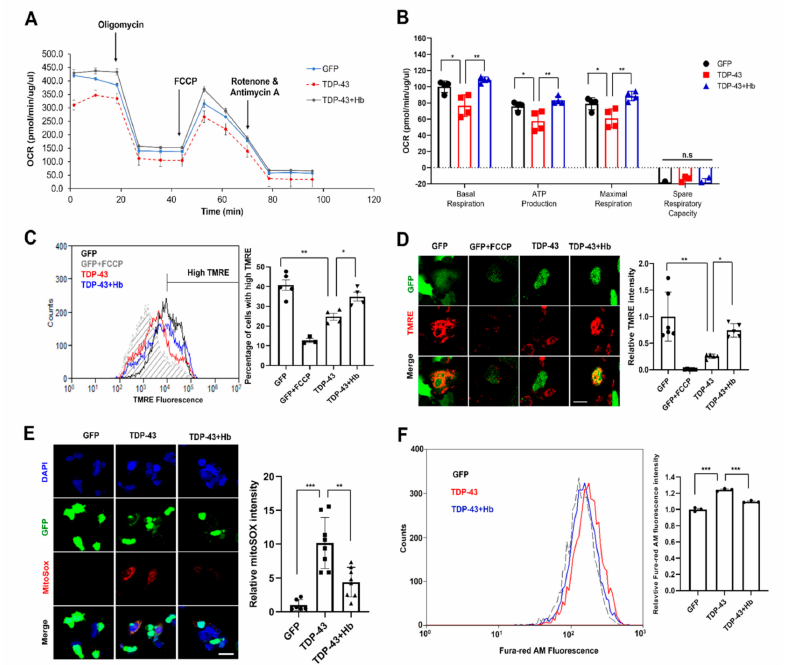
Figure 5. Hydroxocobalamin attenuates TDP-43-induced mitochondrial dysfunction. SH-SY5Y cells were infected with the GFP- or GFP-tagged human WT TDP-43 lentivirus and grown for 2 days. The day before harvest, cells were treated with Hb (10 µ M) for 24 h. ( A ) Mitochondrial function was analyzed by detecting basal respiration, ATP production, maximal reserve and respiratory capacity with a Seahorse XF analyzer. The OCR was normalized to the total protein concentration. ( B ) Quantification of basal respiration, ATP production, maximal reserve and respiratory capacity as a percentage of basal values. Error bars represent the mean values ± SD of three independent experiments. * p < 0.05, ** p < 0.01, and n.s., not significant (one-way ANOVA with Tukey’s multiple comparison test). ( C ) Representative traces of TMRE fluorescence measured using flow cytometry (n = 3, at least 10,000 live cells were analyzed per independent replicate). The mean fluorescence intensity of GFP-tagged cells treated with the decoupling agent FCCP is indicated by the gray dotted line. The average fluorescence intensity of the high TMRE region was measured and reported as a percentage. Data are presented as the means ± SD of three independent experiments. Statistical analyses were performed using one-way ANOVA followed by Tukey’s multiple comparison test. * p < 0.05 and ** p < 0.01. ( D ) Confocal images of SH-SY5Y cells stained with TMRE. All images were collected from the Z-stack and projected as a single image. Cells were stained with TMRE (red) and GFP (green) before imaging. The ratio of TMRE-positive cells in the control or GFP-tagged human WT TDP-43-expressing cells was quantified. Quantification was performed using ImageJ software. Error bars represent the mean values ± SD of three independent experiments. The significance of differences was determined using one-way ANOVA with Bonferroni’s multiple comparison test (* p < 0.05 and *** p < 0.001). Scale bars, 20 µ m. ( E ) Confocal images of SH-SY5Y cells stained with mitoSOX-red after infection with the GFP- or GFP-tagged human WT TDP-43 lentivirus and DAPI (blue) staining. Cells expressing GFP-tagged human WT TDP-43 showed significantly increased mitoSOX signals compared with the control. MitoSOX signals were restored in TDP-43-expressing cells treated with Hb. Quantification was performed using ImageJ software. Data from three independent experiments were analyzed using one-way ANOVA followed by Bonferroni’s multiple comparison test (** p < 0.01 and *** p < 0.001). Scale bars, 25 µ m. ( F ) SH-SY5Y cells overexpressed GFP- or GFP-tagged human WT TDP-43, and the cells were loaded with the Ca 2+ indicator Fura-red/AM and detected using flow cytometry. Data are presented as the means ± SD of three independent experiments. *** p < 0.001 (one-way ANOVA followed by Tukey’s multiple comparison